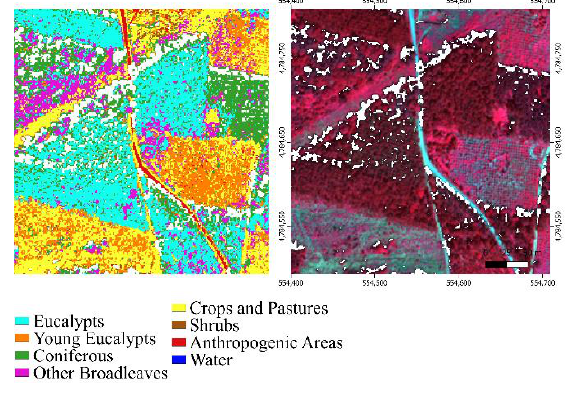
Figure 3. On the left: results of the general classification. On the right: reference WorldView image in false color infrared (B8, B5, B3). White areas in both images correspond to shadowed areas.